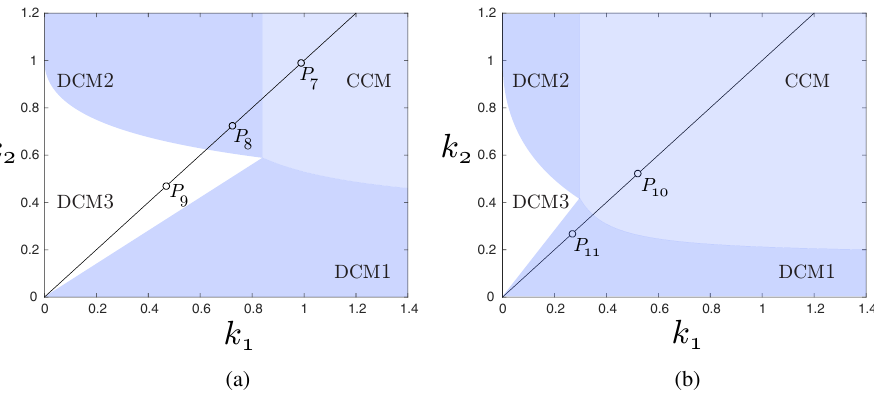
Figure 12. Map of the conduction regions in an open loop for either SEPIC or ´Cuk converters: ( a ) d = 0.4 and ( b ) d = 0.6. The points corresponding to the experimental results are highlighted.